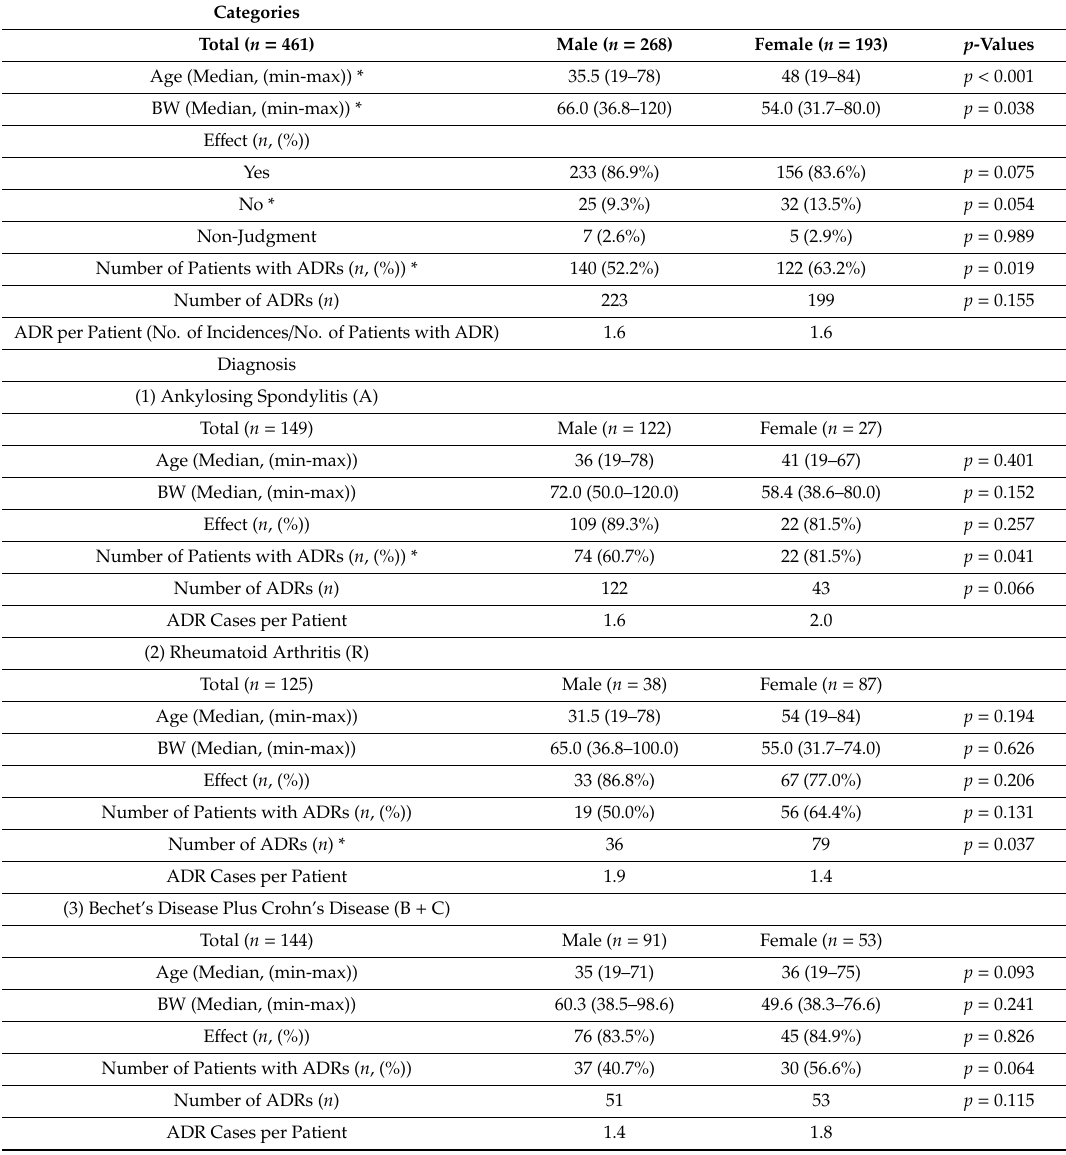
Table 1. The e ffi cacy and adverse drug reactions (ADRs) of adalimumab in patients with records of body weight